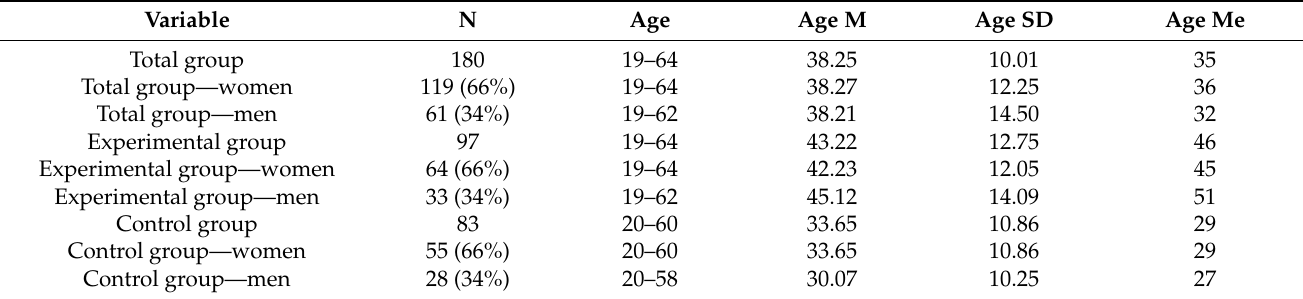
Table 1. Demographic characteristics: experimental and control